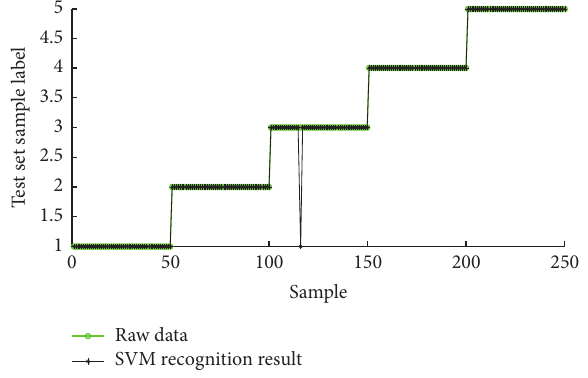
Figure 11: Degradation state recognition results.